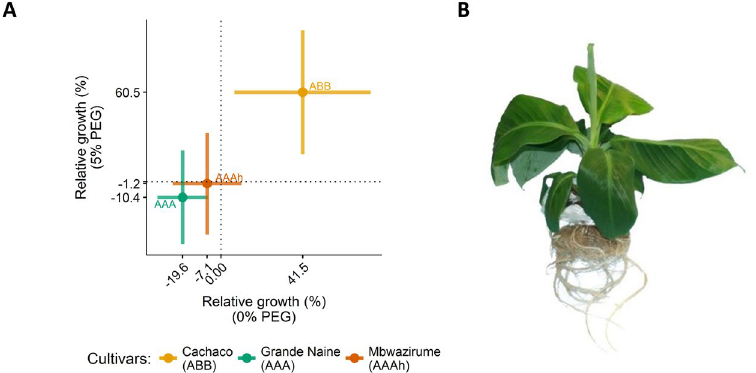
Figure 1. Relative root growth of AAA, AAAh, and ABB cultivars after 21 days of treatment (0 or 5% PEG. ( A ) Normalized dry weight of roots calculated by subtracting a plants dry weight from the treatment group median. Medians per cultivar are indicated with Inter Quartile Range. ( B ) Banana plant grown in the experimental setup.